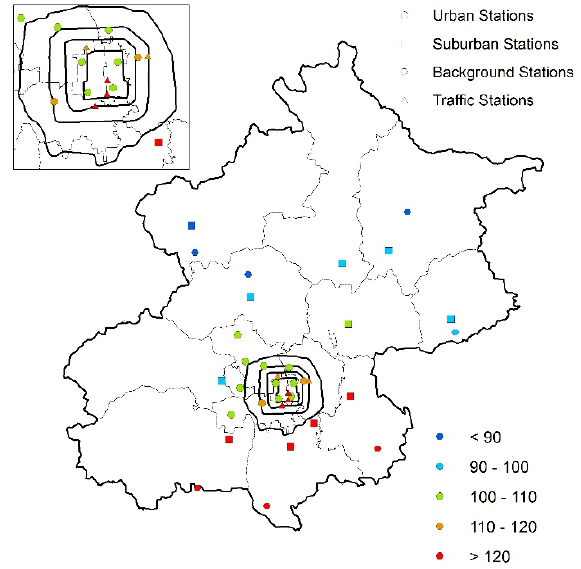
Figure 2. Annual average AQIs of the 35 monitoring